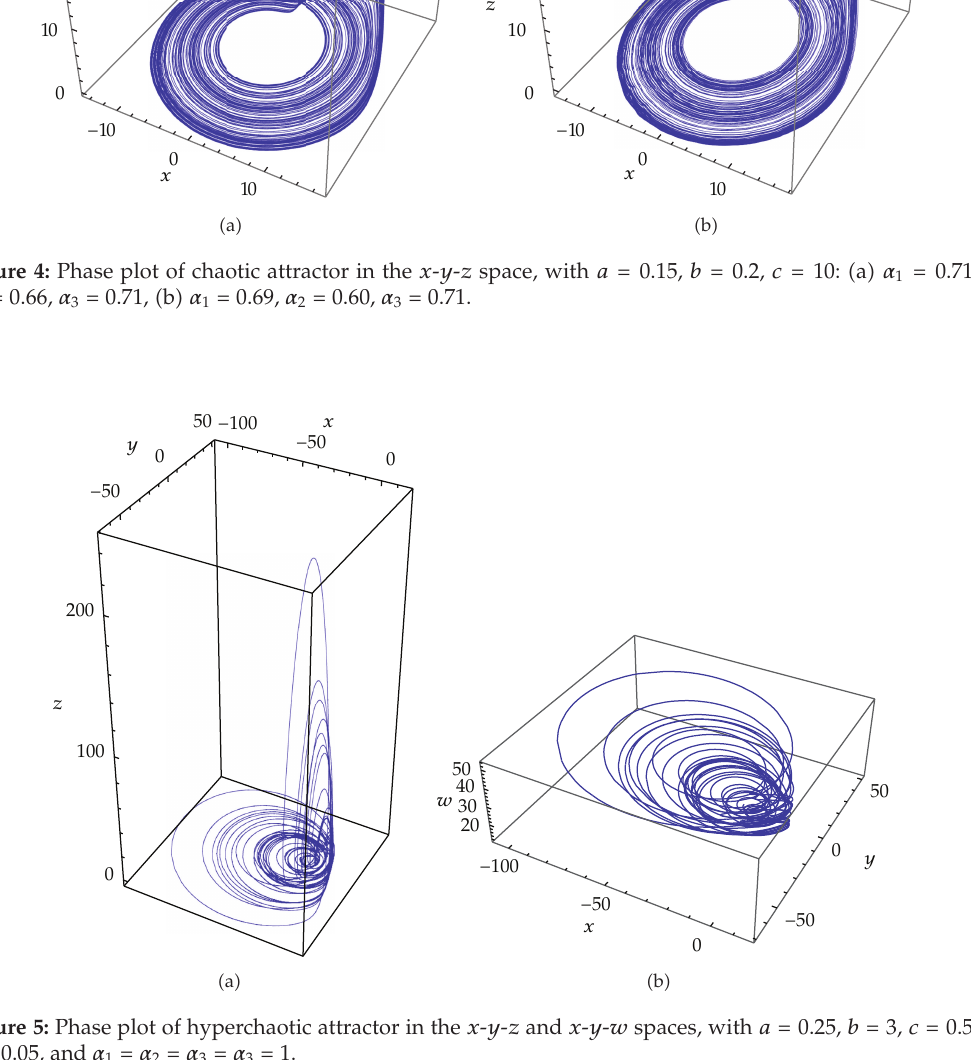
(cid:8) α (cid:8) α (cid:8) α (cid:8) 1. 1 2 3 3